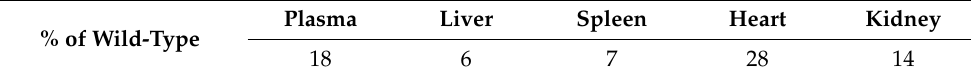
Table 2. Percentage of  -Galactosidase A activity of wild-type mice in treated mice with the GM- SLN vector. % of Wild-Type